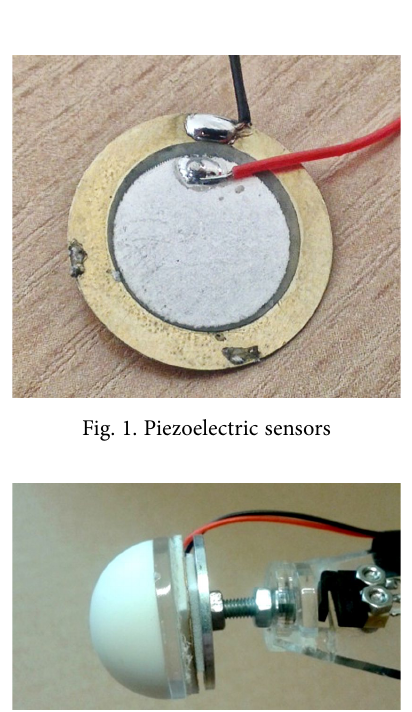
Fig. 2. Foot of a hexapod robot with an integrated piezoelectric sensor